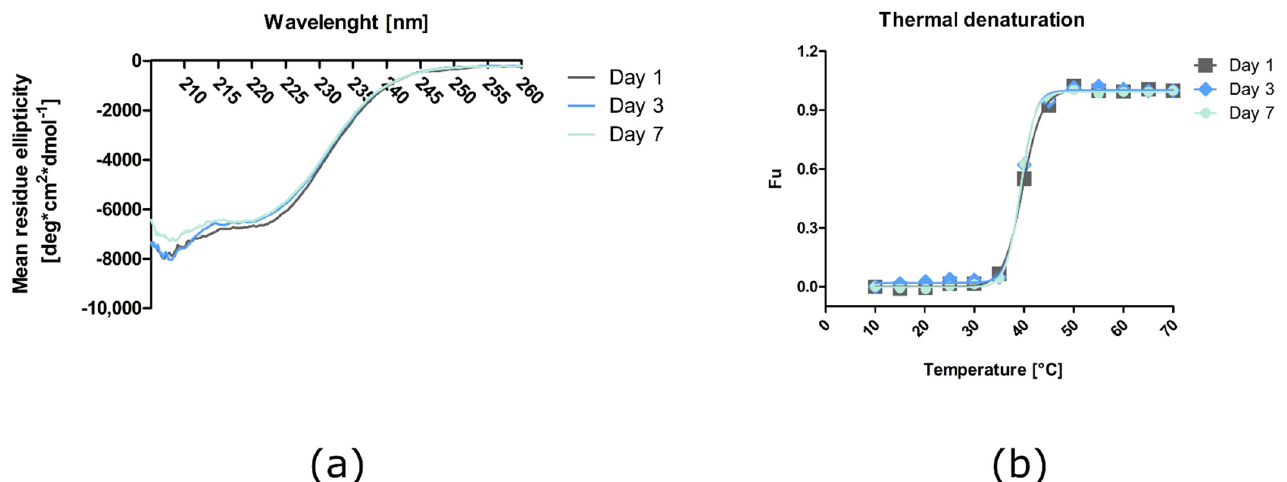
Figure 3. Characterization of the purified recombinant MPP1 protein using circular dichroism spectroscopy. ( a ) CD spectra of MPP1 protein 1, 3, and 7 days after dialysis recorded at 20 °C. ( b ) Thermal denaturation of MPP1 protein reflected via changes in ellipticity at 222 nm. The MPP1 was stored at 4 °C. Fu—fraction unfolded.